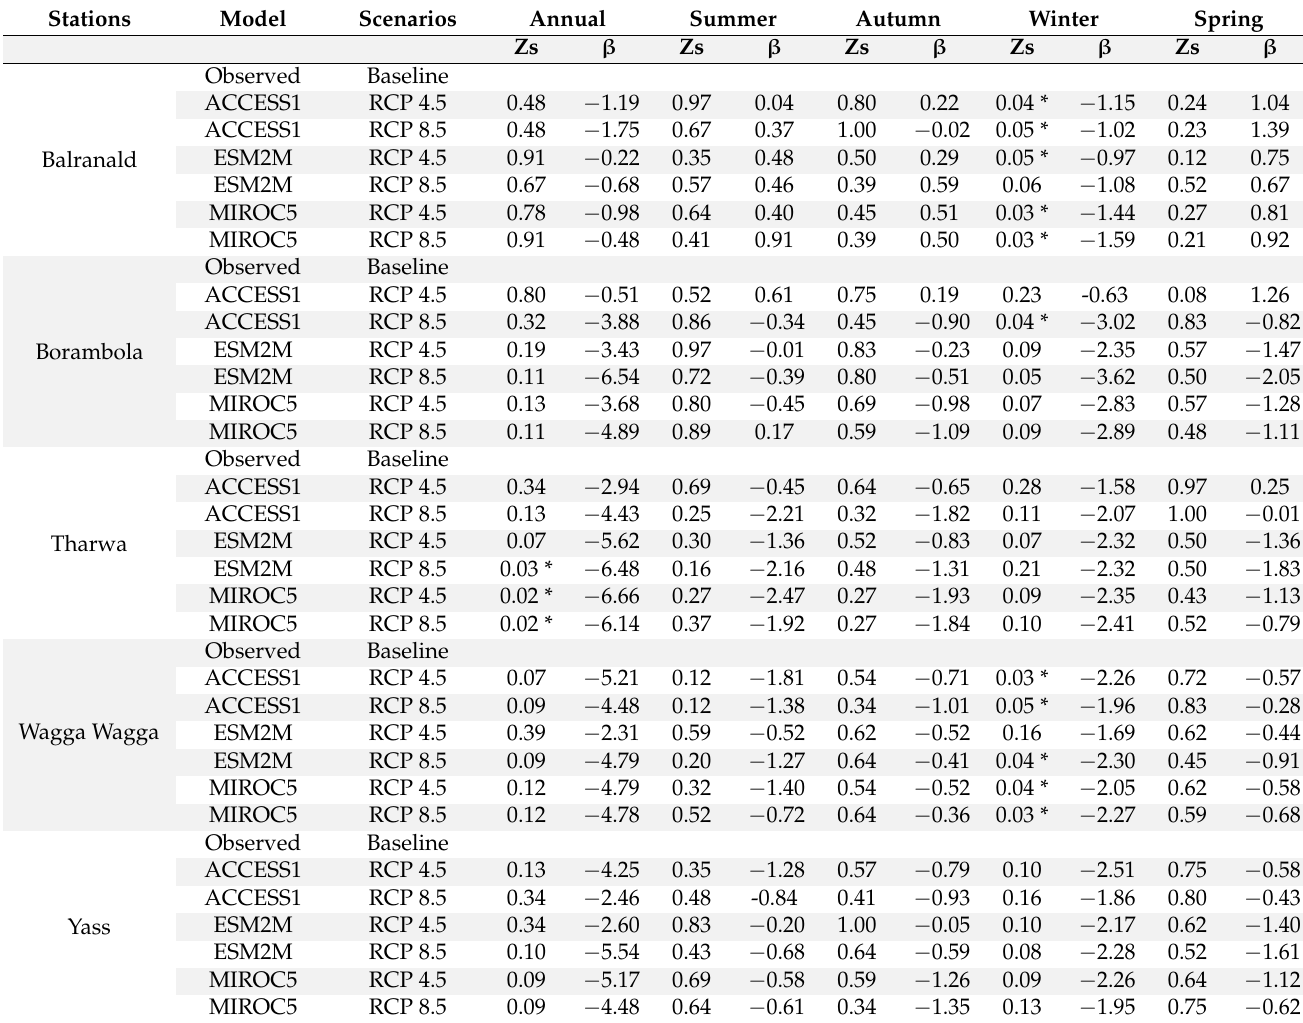
Table 4. Seasonal and Annual trends of rainfall at five stations for the period of 2016–2045 under all climate models and RCPs.